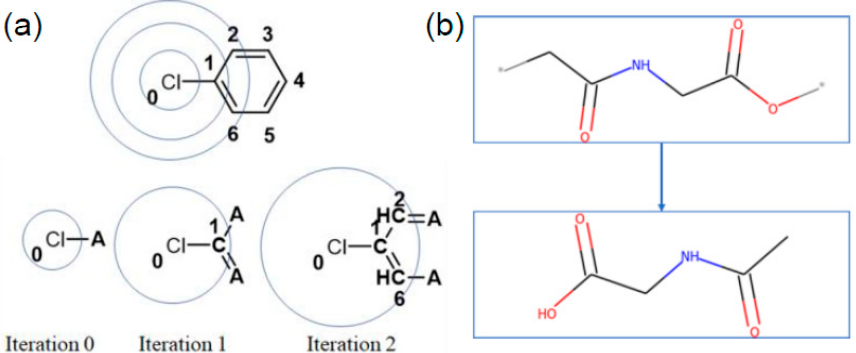
Figure 1. ( a ) Example of a chlorine atom in chlorobenzene finding its neighboring atoms to define chemical environment for an ECFP with radius 2. Reproduced from Lee [20]. ( b ) Example of hydrogen capping a monomer prior to calculating its ECFP.